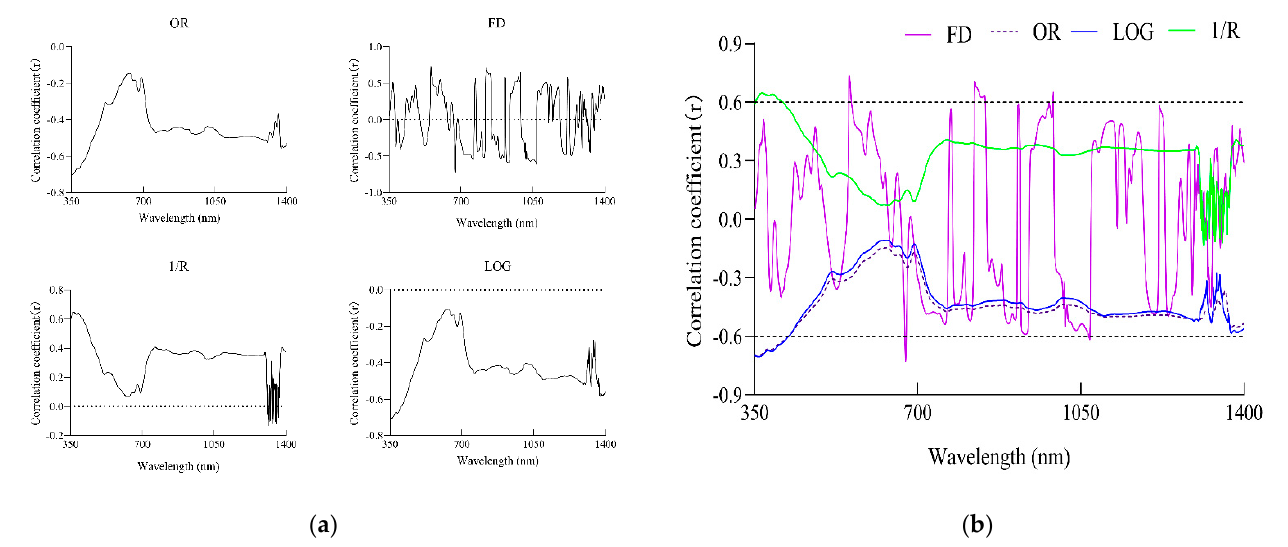
Figure 4. Correlation of LAI with original spectral reflectance and its transformation. ( a ) Separate spectral processing and LAI correlation; ( b ) all spectral treatments correlated with LAI. Figure 4b was made based on the above analysis. The function curve of y = |0.6|